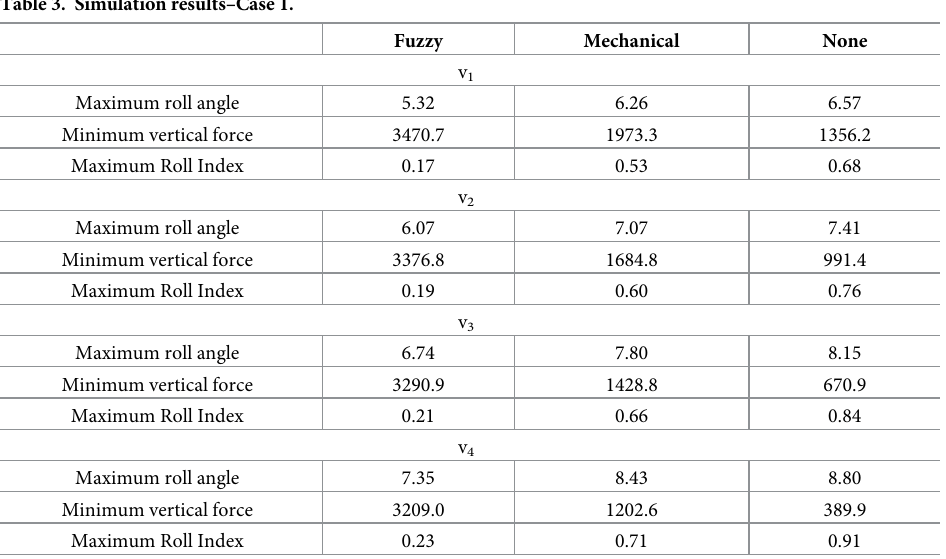
Table 3. Simulation results–Case